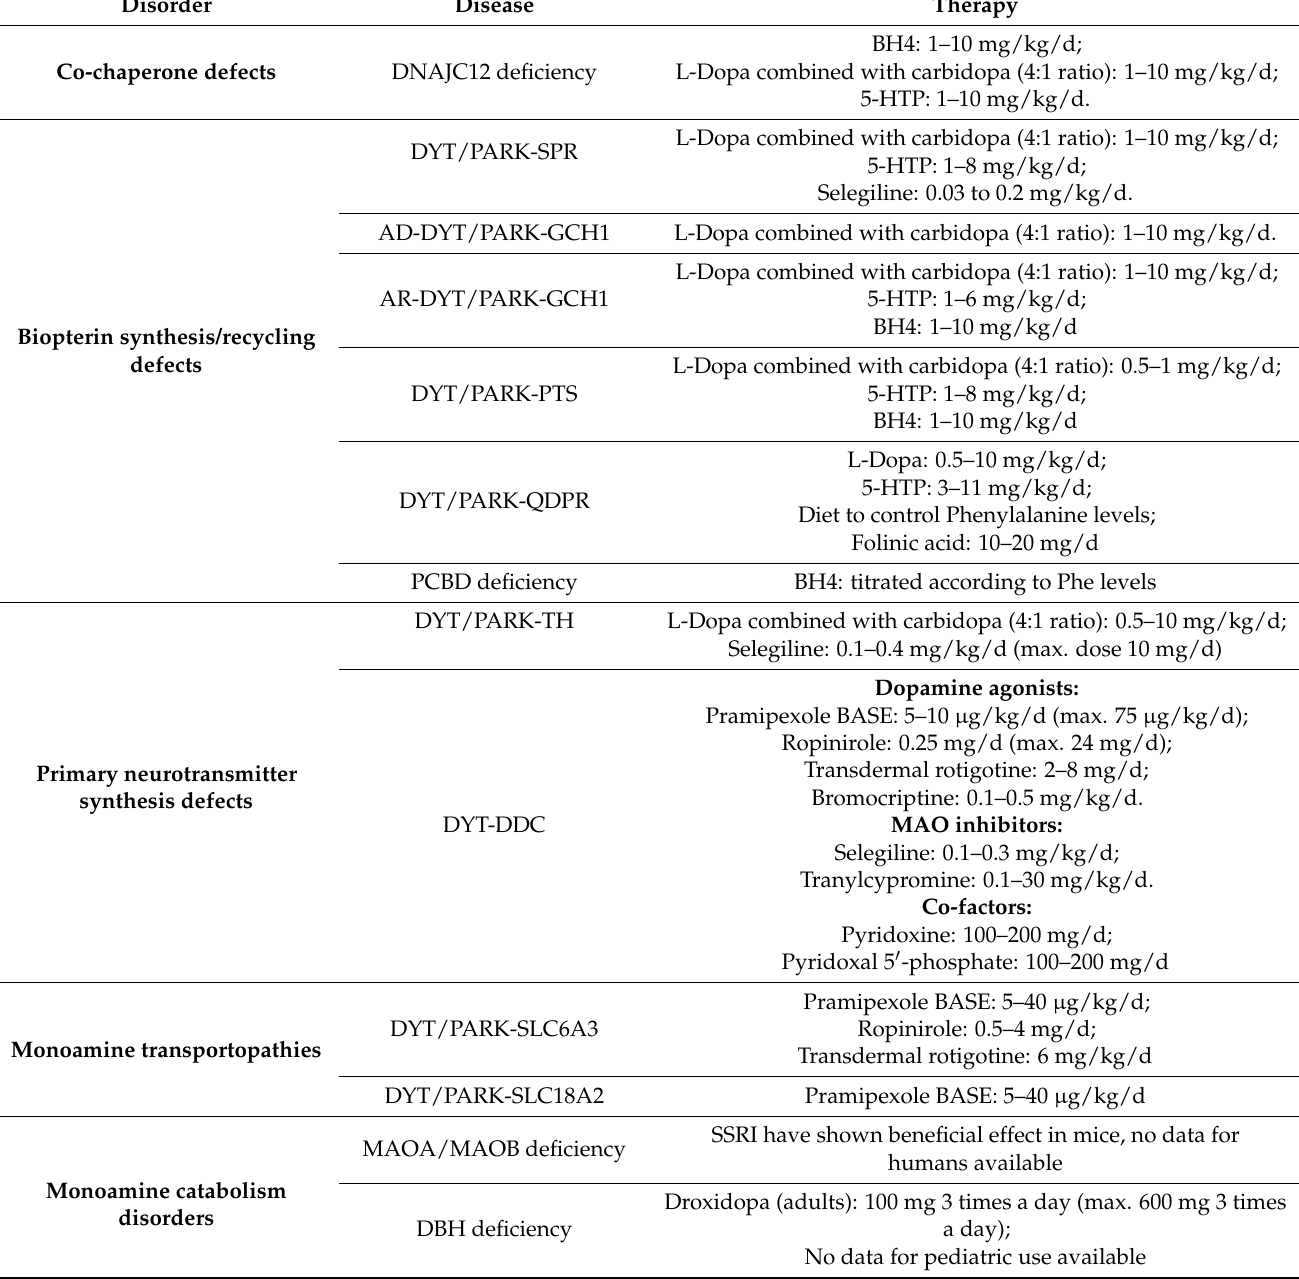
Table 3. Available pharmacological treatments for inherited biogenic amine metabolism